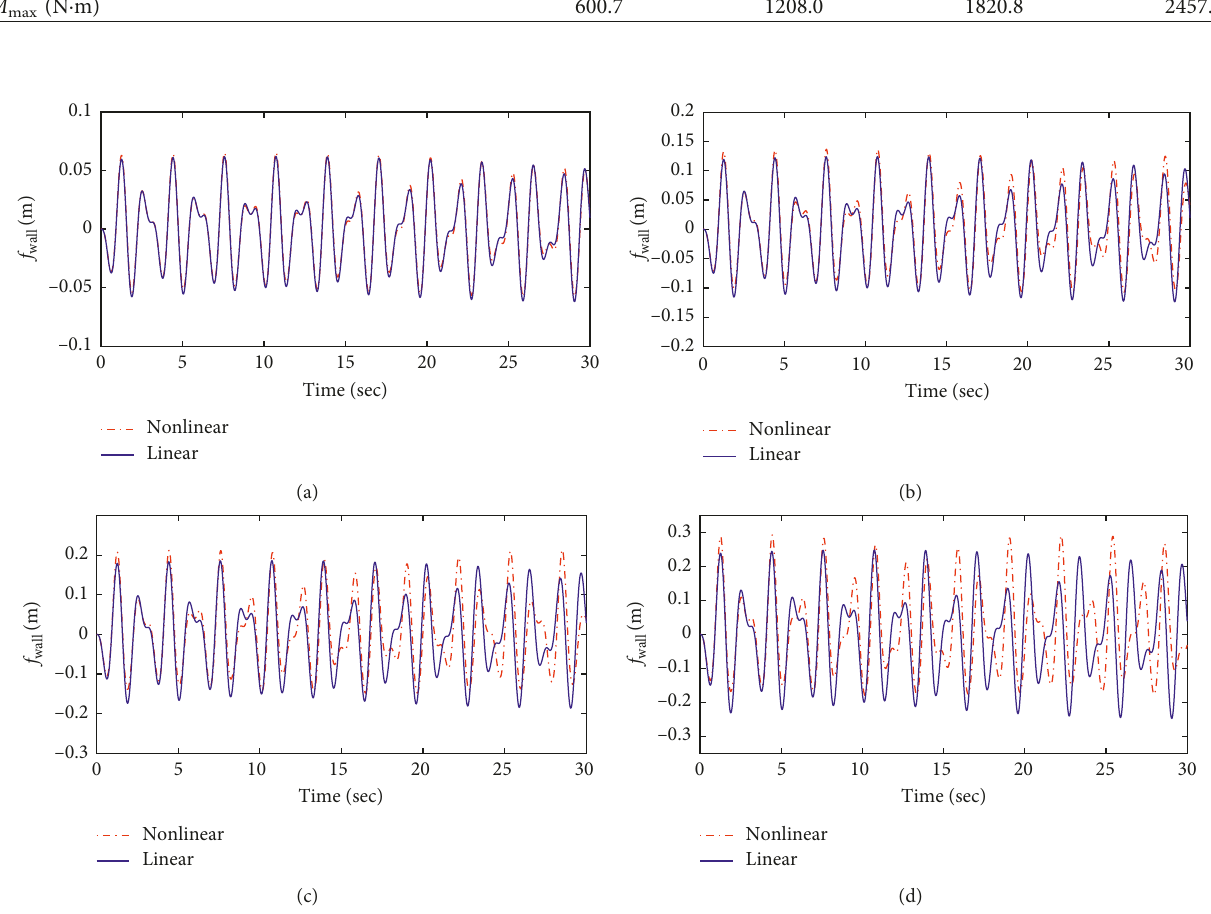
Figure 19: Time history of the surface wave height at the container wall under the lateral harmonic excitation for ω � 6 rad/s and X (a), 0.02m (b), 0.03 m (c), and 0.04m (d), respectively.